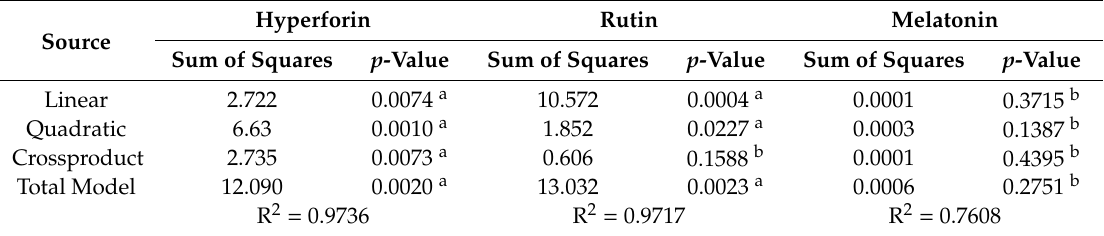
Table 2. ANOVA for response surface models pertaining to the content of bioactive